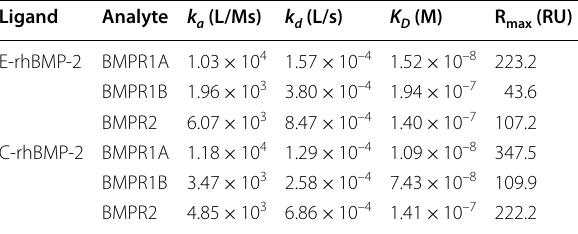
k a , association rate; k d , dissociation rate; K D , equilibrium dissociation rate constant; R max , analyte binding capacity of the surface